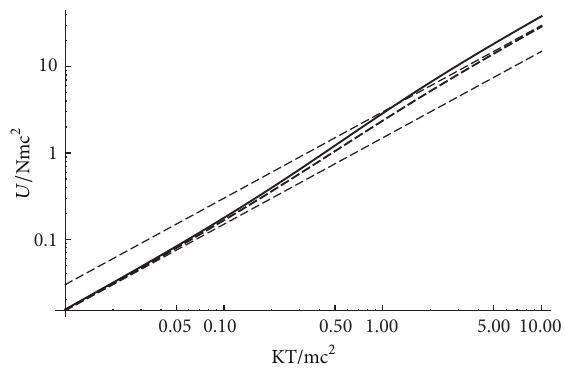
Figure 2: The dashed curves represent the unmodified specific heat and its non- and ultrarelativistic limits. The solid curve represents the modified specific